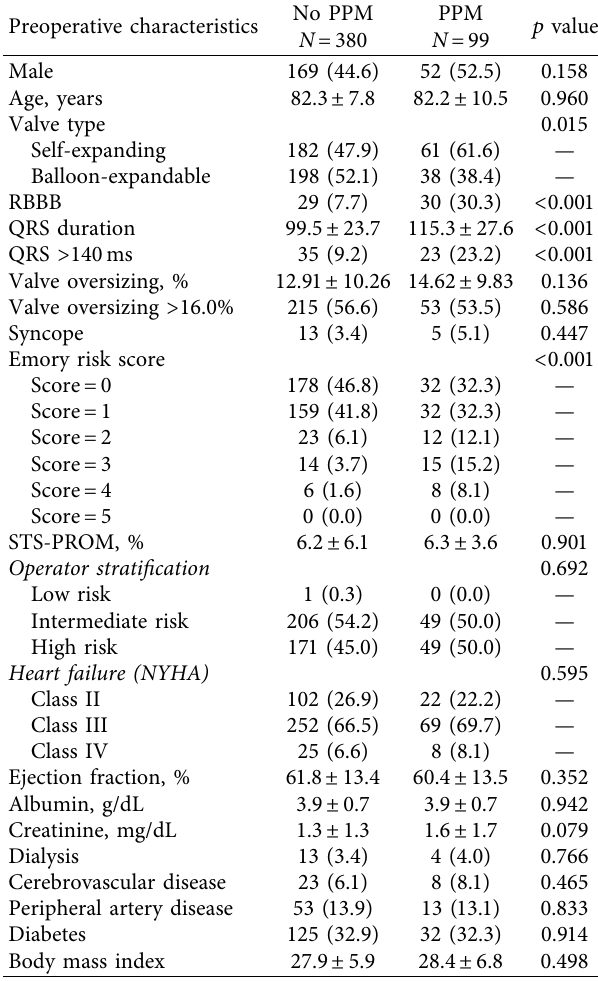
Table 1: Baseline patient characteristics: post-TAVR PPM versus no